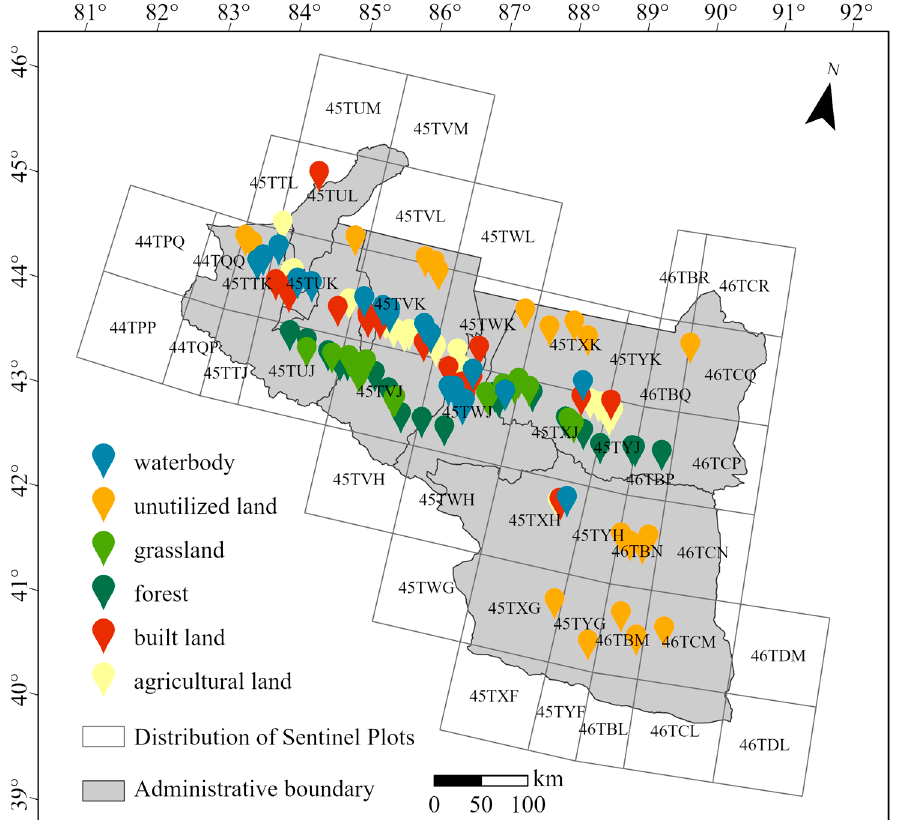
Figure A1. The distribution of sampling points for LULC.